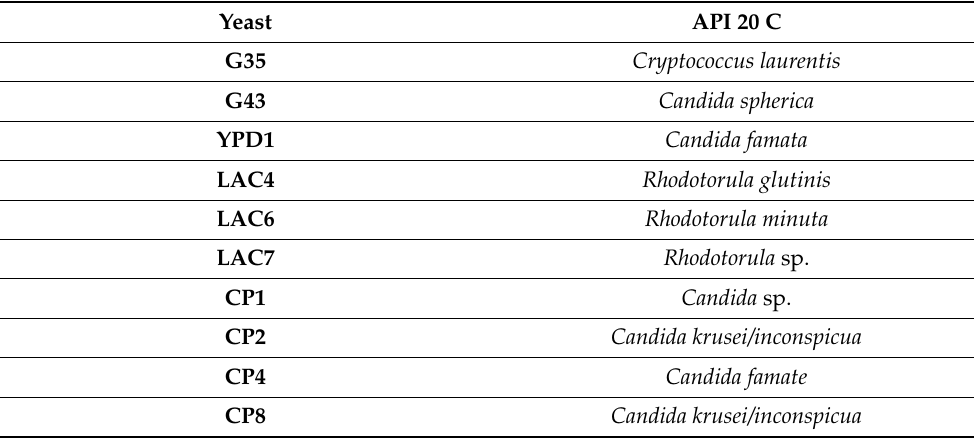
Table 1. Yeasts characterized biochemically isolated from bay